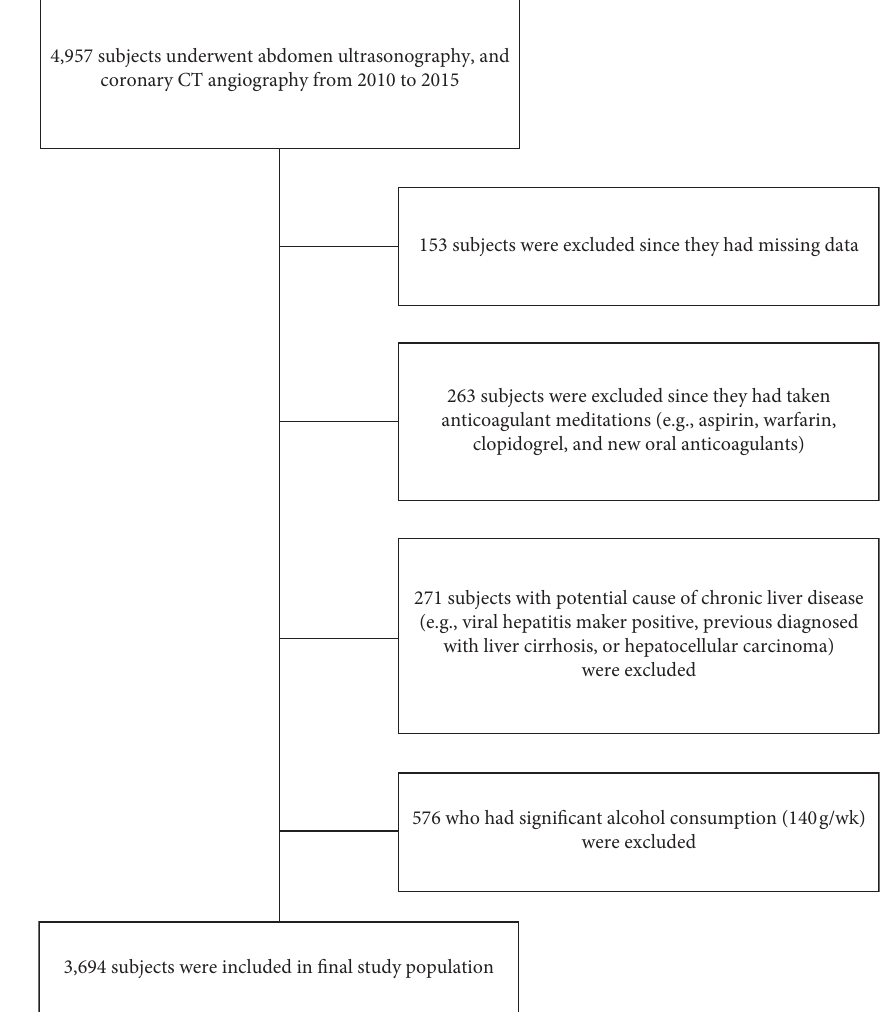
Figure 1: Flowchart of the included study